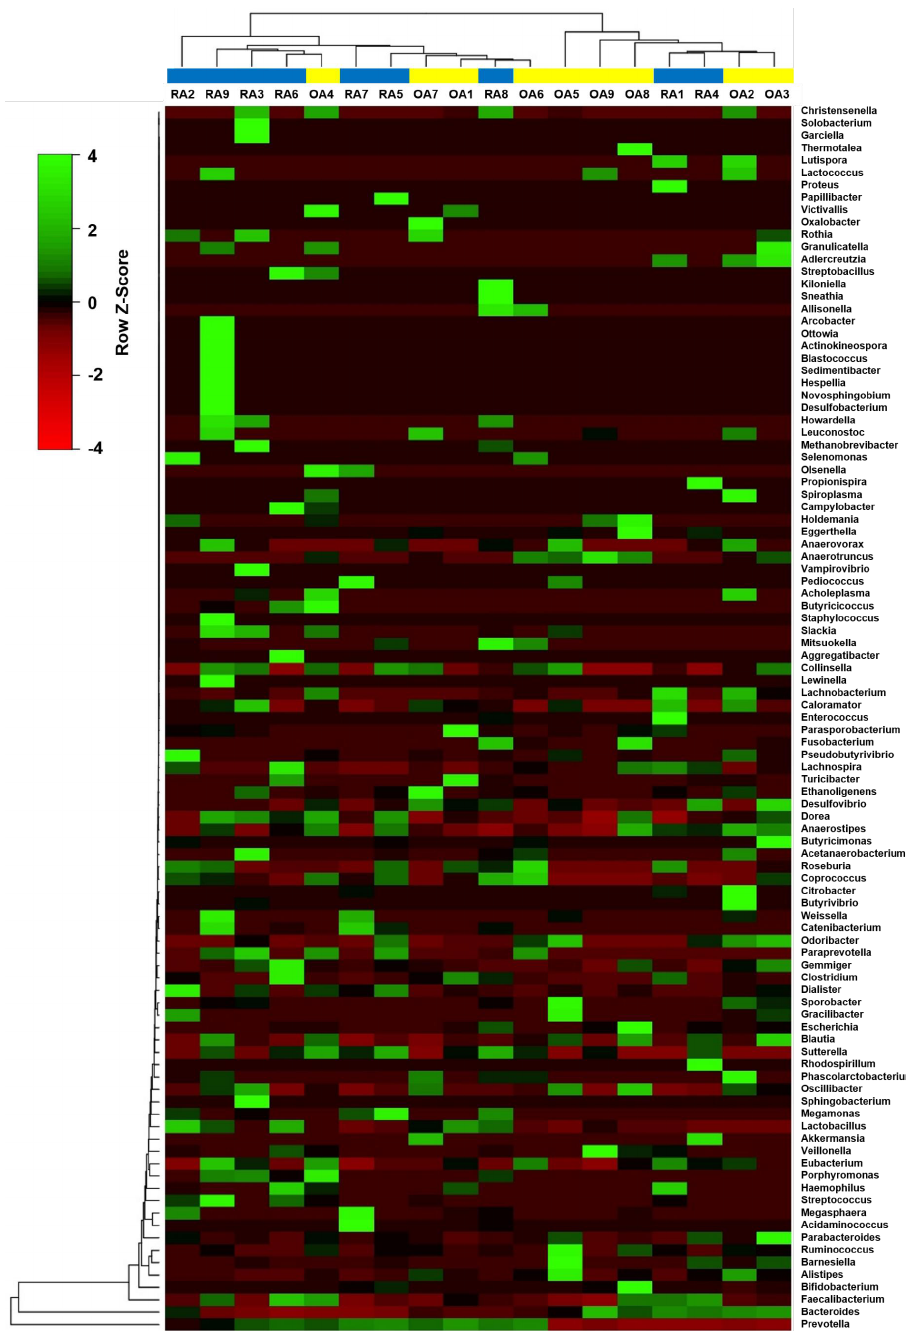
Figure 7. Heatmap of the average linkage hierarchical clustering, based on the Euclidean distance Figure 7 measurements of bacterial genera obtained from nine samples from the RA and OA